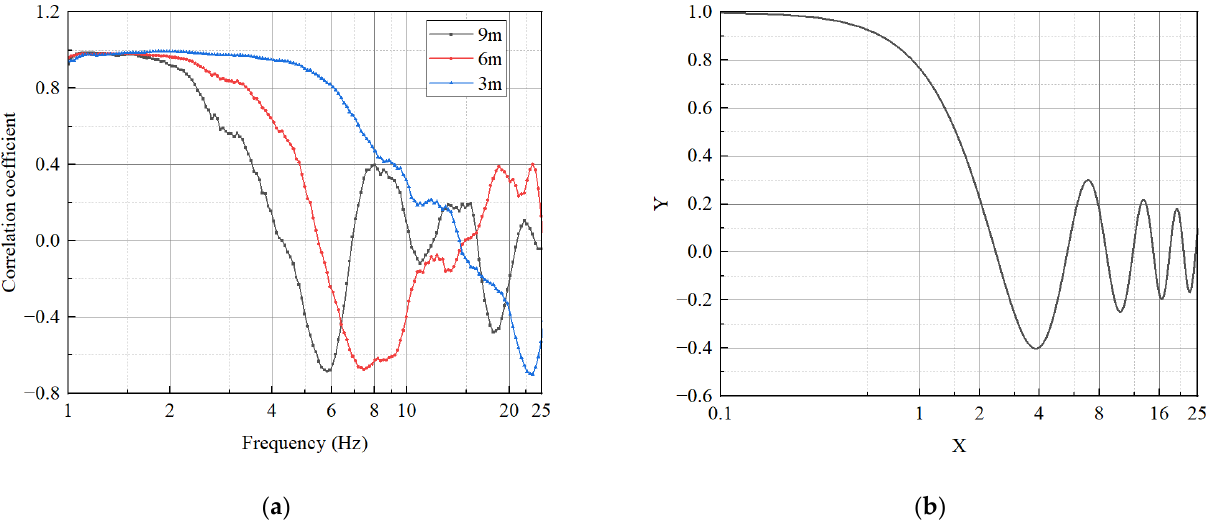
Figure 3. Correlation coefficient curves and zero-order first-class Bessel function curve. ( a ) Correlation coefficient curves; ( b ) J 0 : Zero-order first-class Bessel function